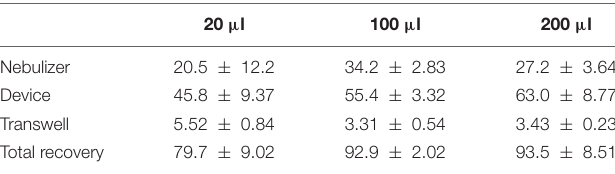
TABLE 1 | Total recovery of substance in the system after nebulization and deposition on the apical side of permeable supports.